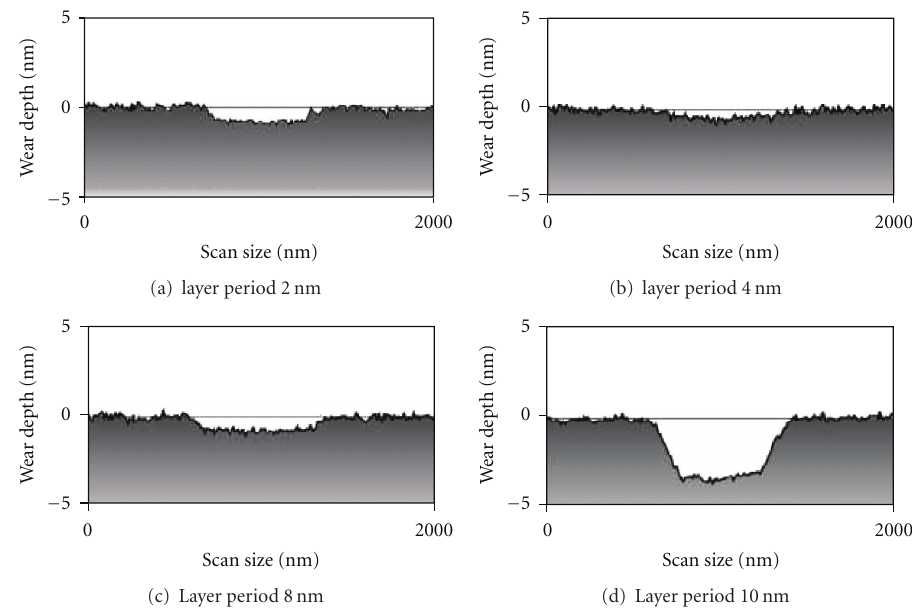
Figure 9: Dependence of nanometer-scale wear properties on layer period of (CN/BN)n multilayer films obtained by applying a load of 10 µ N and one number of scanning cycle.